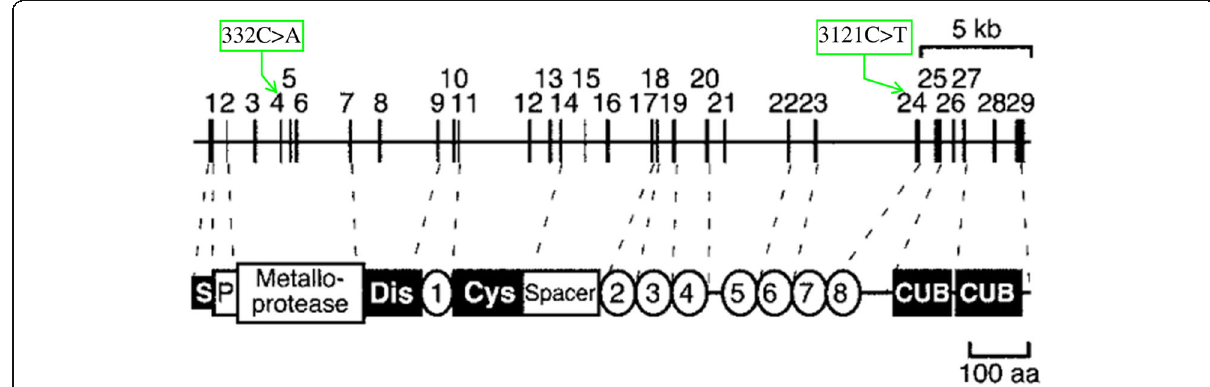
Fig. 2 Schematic illustration of the structure of ADAMTS13.Exons 1 – 29 are shown to scale above the illustration of the protein structure. Dashed lines indicate the correspondence between the boundaries of exons and the boundaries of structural domains. S, signal peptide; P, propeptide; Dis, disintegrin-like; Cys, Cys-rich. TSP1 repeats are numbered 1 –